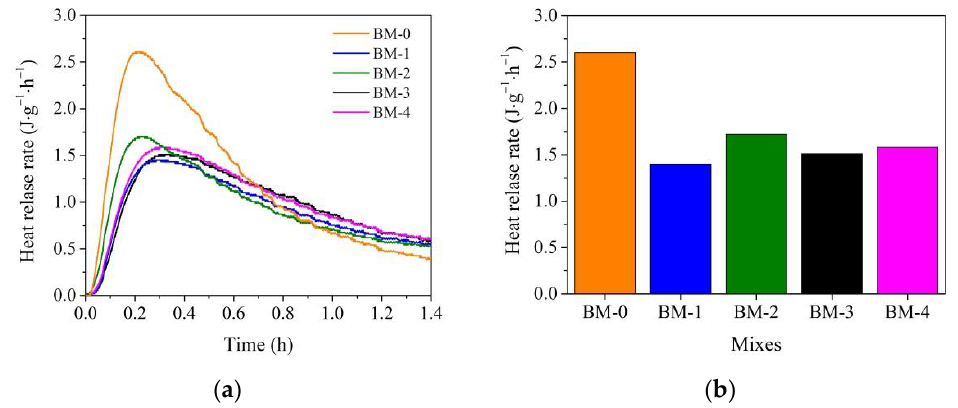
Figure 4. Wetting heat release rate for BM-0 – BM-4 mixes: ( a ) curves, ( b ) maximum values during first 20 min.